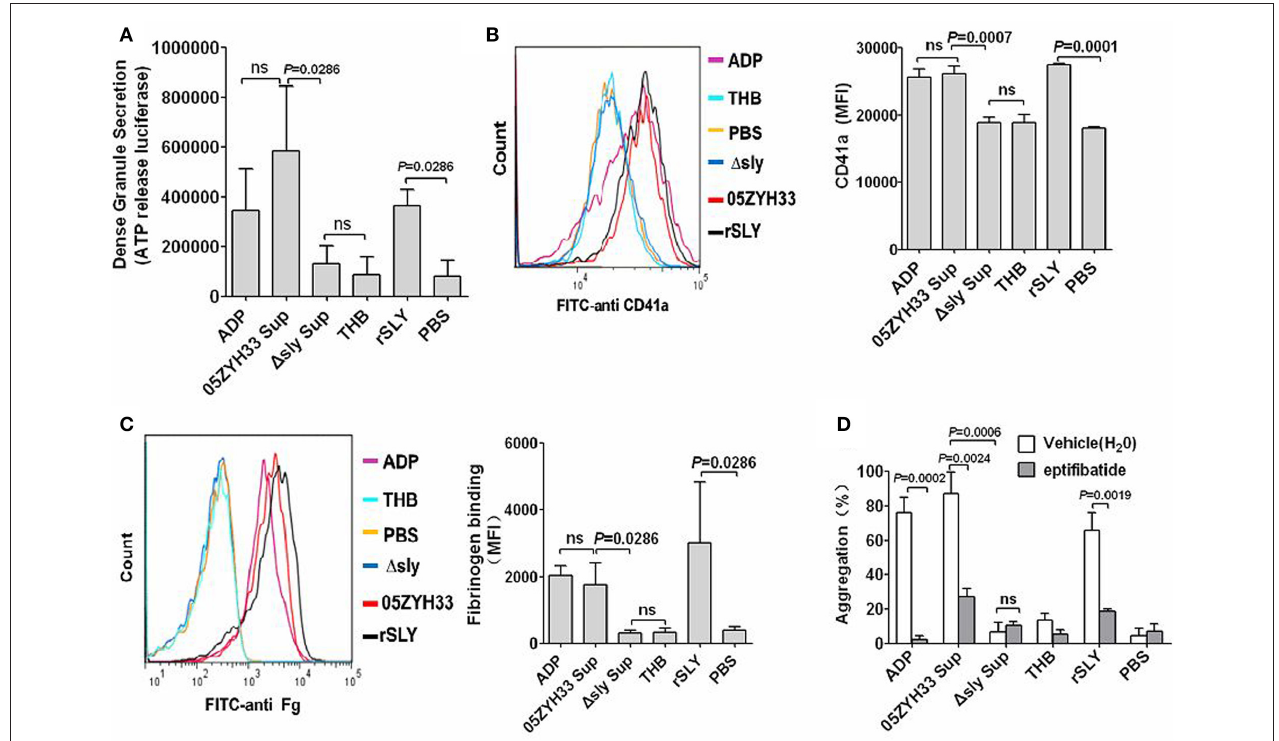
FIGURE 2 | Platelet activation by SLY, and GPIIb/IIIa (CD41a) mediated the SLY-induced platelet aggregation. (A) SLY induces dense granule release from platelets. PRP was incubated with S. suis culture supernatant or SLY protein (1 µ g/ml). The Mann–Whitney U-test was used for statistical analysis. (B,C) S. suis culture supernatant or rSLY protein (1 µ g/ml)-induced surface GPIIb/IIIa (CD41a) increase and fibrinogen binding to platelets in human blood was assessed by flow cytometry (Methods Section). Representative histograms for the MFI of CD41a/fibrinogen binding are shown in ( B , left panel). Unpaired two-tailed Student’s t -test was used for (B) statistical analysis. Mann–Whitney U-test was used for (C) statistical analysis. (D) PRP was preincubated with eptifibatide (10 µ M) for 15 min prior to addition of S. suis supernatant or SLY protein. Platelet aggregation was expressed as a final percentage of light transmission. Unpaired two-tailed Student’s t -test was used for statistical analysis. ADP (20 µ M) was used as the positive control for platelet activation. THB and PBS were the negative controls for the culture supernatant and proteins, respectively. Data in panels (A–D) are expressed as the mean ± SD of three independent experiments, with each experiment using blood from a different donor. P < 0.05 is considered to be the threshold for statistical significance; ns, not significant; 05ZYH33, wild type strain; 1 sly, isogenic mutant of sly; Sup, supernatant; rSLY, recombinant